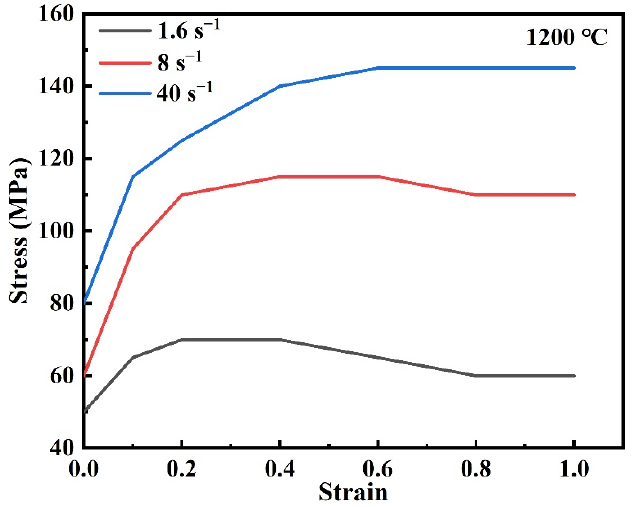
Figure 5. Flow stress of 42CrMo4 at 1200 °C obtained from the software.